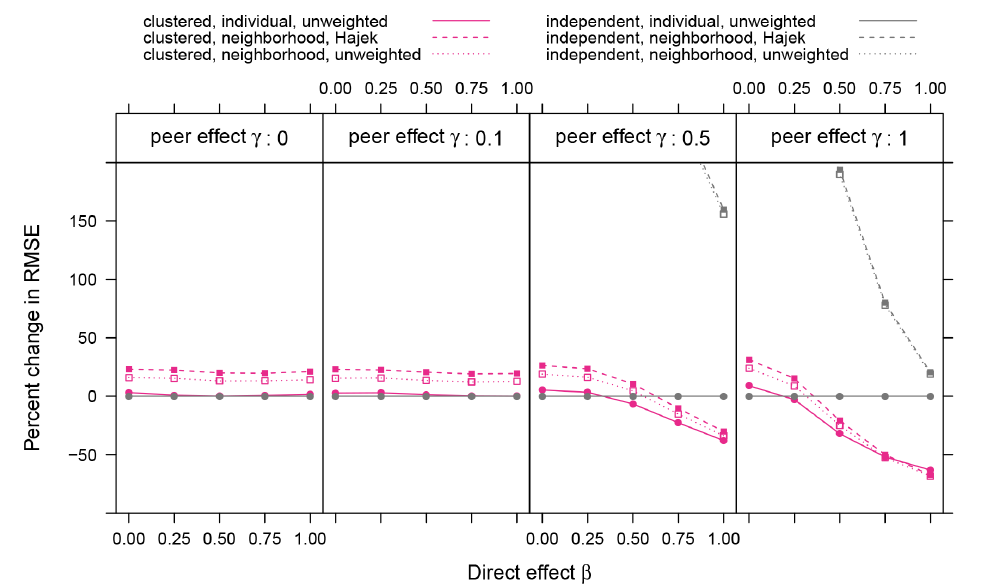
Figure 6 Percent change in root-mean-squared-error (RMSE) compared with independent assignment with the simple difference-in-means estimator. Using the neighborhood condition with independent assignment results in large increases in variance: for the two smaller values of u , this produces an almost 400% increase in RMSE. For this reason, the y -axis is limited to not show these cases. Rewiring probability u = uu